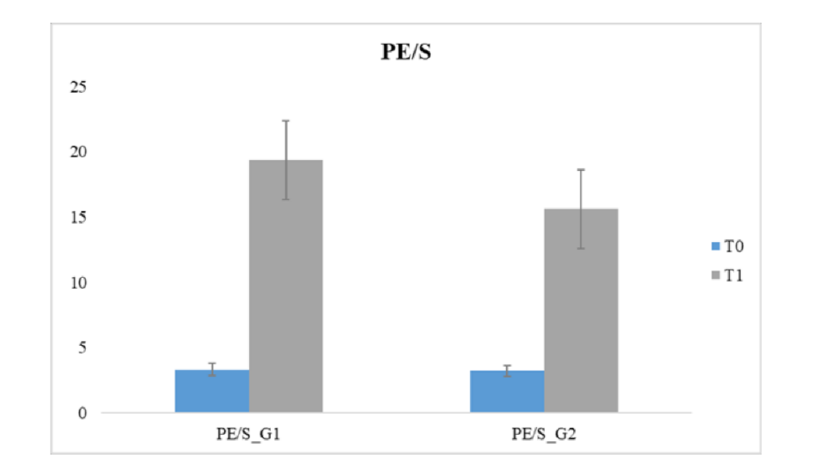
Figure 3. Comparison of the two groups between T0 and T1 at task 3 (ESPE). Comparison of the group 1 and 2 between T0 and T1 on task 3 (ESPE).